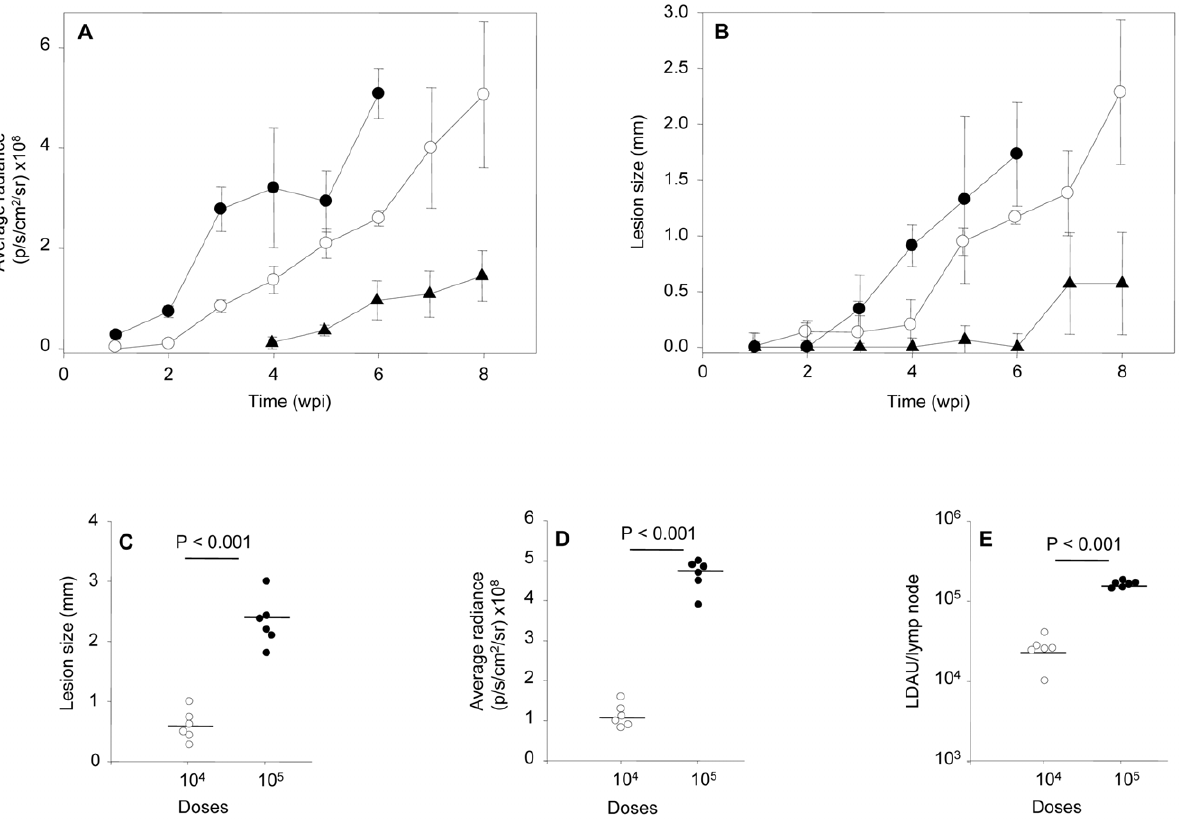
N ), 10 5 N ). Data were